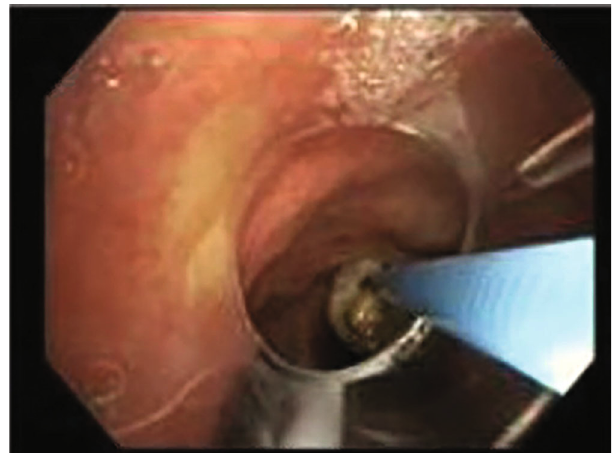
Figure 5: Bronchoscopic view of an aspirated crown at the end of